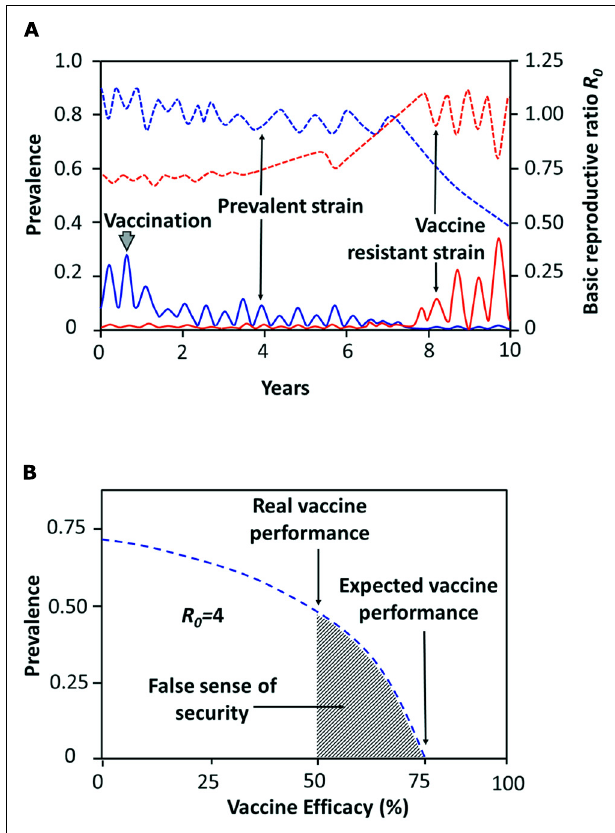
FIGURE 8 | Prediction for emergence of resistant-vaccine Brucella strains and the false sense of security. (A) Immunization with low efficacy vaccines may change the competitive balance between Brucella virulent strains. Before vaccination (6–8 months of age) one prevalent strain is observed (blue line). After vaccination of 100% of the susceptible animals with a low efficacy vaccine that only gives 30–40% protection rate, the vaccine-resistant strain (red line) may eventually emerge with a competitive advantage that is only evident after a large proportion of the population has been vaccinated over the years.The vaccine resistant-strain arises from the Brucella pool, either through mutation of the prevalent strain or by selection of previously existing strains. Only after the R 0 of the vaccine-resistant strain has exceeded that of the prevalent strain, then a new brucellosis epidemic event develops. Solid blue and red lines correspond to the prevalence ordinate; dashed lines correspond to the R 0 ordinate (adapted from Scherer and McLean, 2002). (B) Reduction in brucellosis prevalence below the critical vaccination threshold (expected vaccine performance) with an anti- Brucella vaccine efficacy of 75% and R 0 = 4. In a bovine close homogeneous population a lower value for R 0 would be associated with a lower Brucella prevalence.The false sense of security (shadow area) for a given vaccine lays between the expected vaccine performance (e.g., 75%) and the real vaccine performance (e.g.,